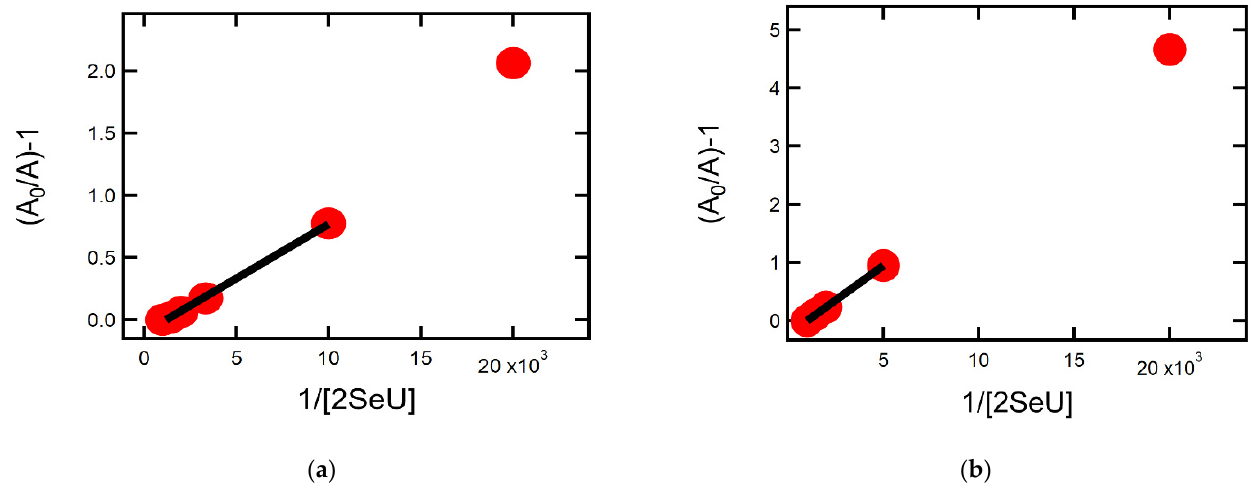
Figure 3. Dependence of the term A 0 / A − 1 at λ = 440 nm on the reciprocal of 2-SeU concentration in the pulse radiolysis of N 2 O-saturated unbuffered aqueous solutions at pH = 4 ( a ) and pH 10 ( b ).